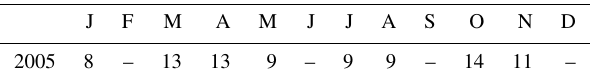
Table 1. Number of nights per month with airglow observations